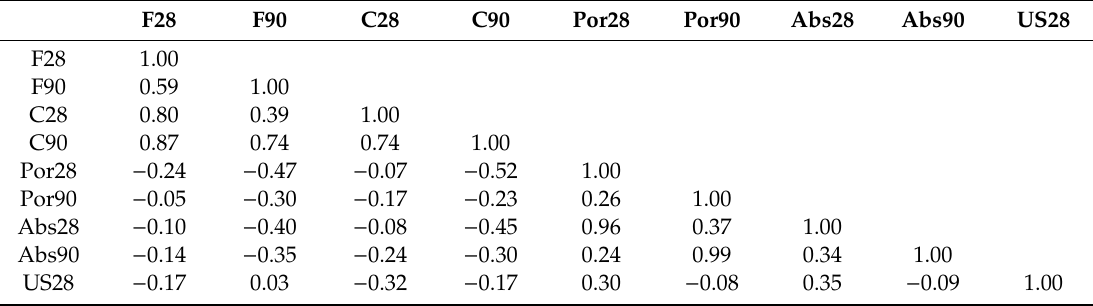
Table 7. Correlation between studied